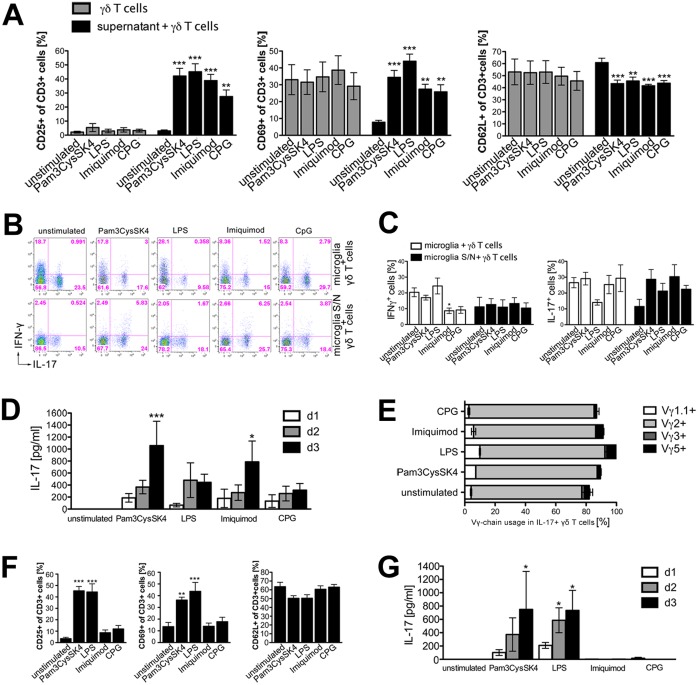
Supernatants derived from microglia stimulated through TLRs activate naïve γδ T cells and induce expression of IL-17, but not IFN-γ.
(A) Microglia were stimulated with the TLR ligands Pam3CysSK4 (100 ng/ml), LPS (100 ng/ml), imiquimod (10 μg/ml), or CpG (1 μM) for 24 h. Microglia-conditioned supernatants were transferred to freshly isolated naïve γδ T cells, or γδ T cells were directly stimulated with the TLR ligands. Unstimulated cells served as a control. After 2 days, γδ T cells were collected and analyzed by flow cytometry regarding CD3, CD25, CD69, and CD62L expression. Each condition was performed in duplicate and averaged. Mean ± SEM of 3 to 9 individual experiments. (B, C) Microglia were stimulated for 24 h with TLR ligands as described in (A) for 24 h. Subsequently, either the microglia-conditioned supernatants were transferred to freshly isolated naïve γδ T cells or γδ T cells were co-cultured with both microglia and their supernatant. After 3 days, γδ T cells were harvested, restimulated with PMA/ionomycin, and analyzed by flow cytometry for intracellular IFN-γ and IL-17 expression. (C) Each condition was performed in duplicates and averaged. Mean ± SEM of 4 individual experiments. (D) γδ T cells were cultured with microglia-conditioned supernatant, as described in (A). After indicated time points supernatants were analyzed by ELISA regarding IL-17 production. Each condition was performed in duplicates and averaged. Mean ± SEM of 3 to 7 experiments. (E) Overview of Vγ-chain usage (Vγ1.1, Vγ2, Vγ3 and Vγ5) found on IL-17+ γδ T cells activated by supernatants derived from TLR-stimulated microglia. Mean ± SEM of 3 individual experiments. (F) Bone marrow-derived macrophages (BMDMs) were stimulated for 24 h with various TLR ligands as named in (A). BMDM-conditioned supernatants were transferred to freshly isolated naïve γδ T cells. γδ T cells were collected after two days and analyzed by flow cytometry regarding CD3, CD25, CD69, and CD62L expression, and supernatants were collected after one, 2 and 3 days, and analyzed regarding the presence of IL-17 by ELISA (G). Each condition was performed in duplicate and averaged. Mean ± SEM of 4 to 5 individual experiments. (A), (C) and (F) ANOVA with Dunnett´s multiple comparison post test of each ligand vs. unstimulated control, (A) p = 0.7198, p<0.0001, p = 0.9415, p<0.0001, p = 0.9707, p = 0.0001, (C) p = 0.0061, p = 0.9883, p = 0.2590, p = 0.1599, (E) p<0.0001, p = 0.0004, p = 0.0521. (D) and (G) 2-way ANOVA with Bonferroni post test compared to unstimulated control; p*<0.05, p***<0.001.